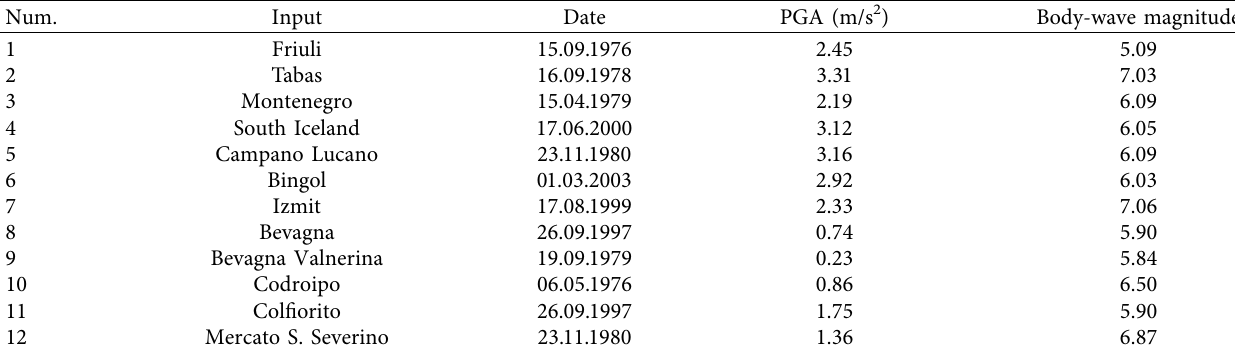
Table 3: Parameters of earthquake ground motions.